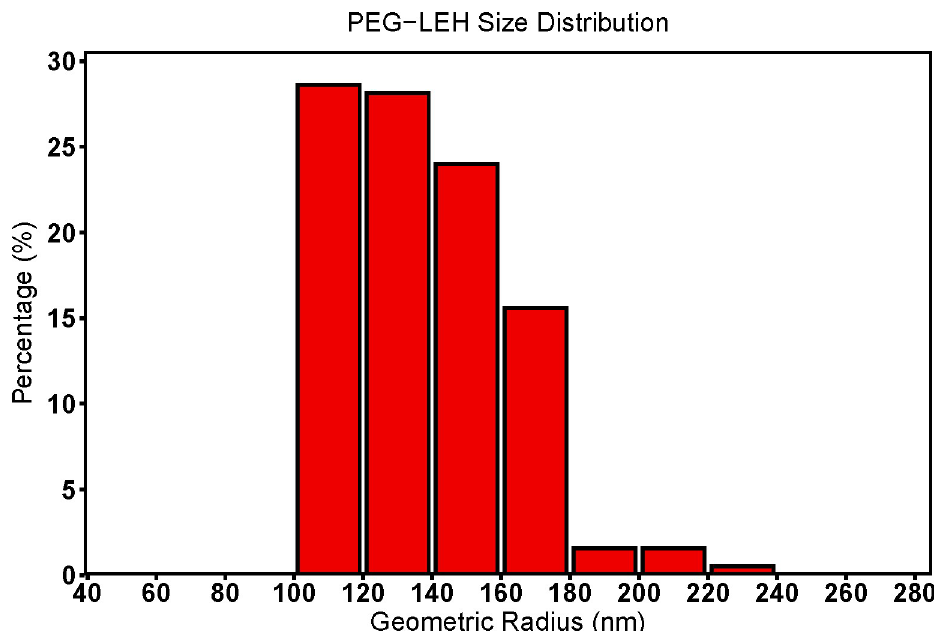
Fig 2. PEG-LEH nanoparticle size distribution. A typical PEG-LEH nanoparticle absolute size distribution plot generated using multi-angle static light scattering data obtained from a Dawn Heleos 1 MASLS photometer. Nanoparticle fractionation was achieved using an Eclipse 1 A4F